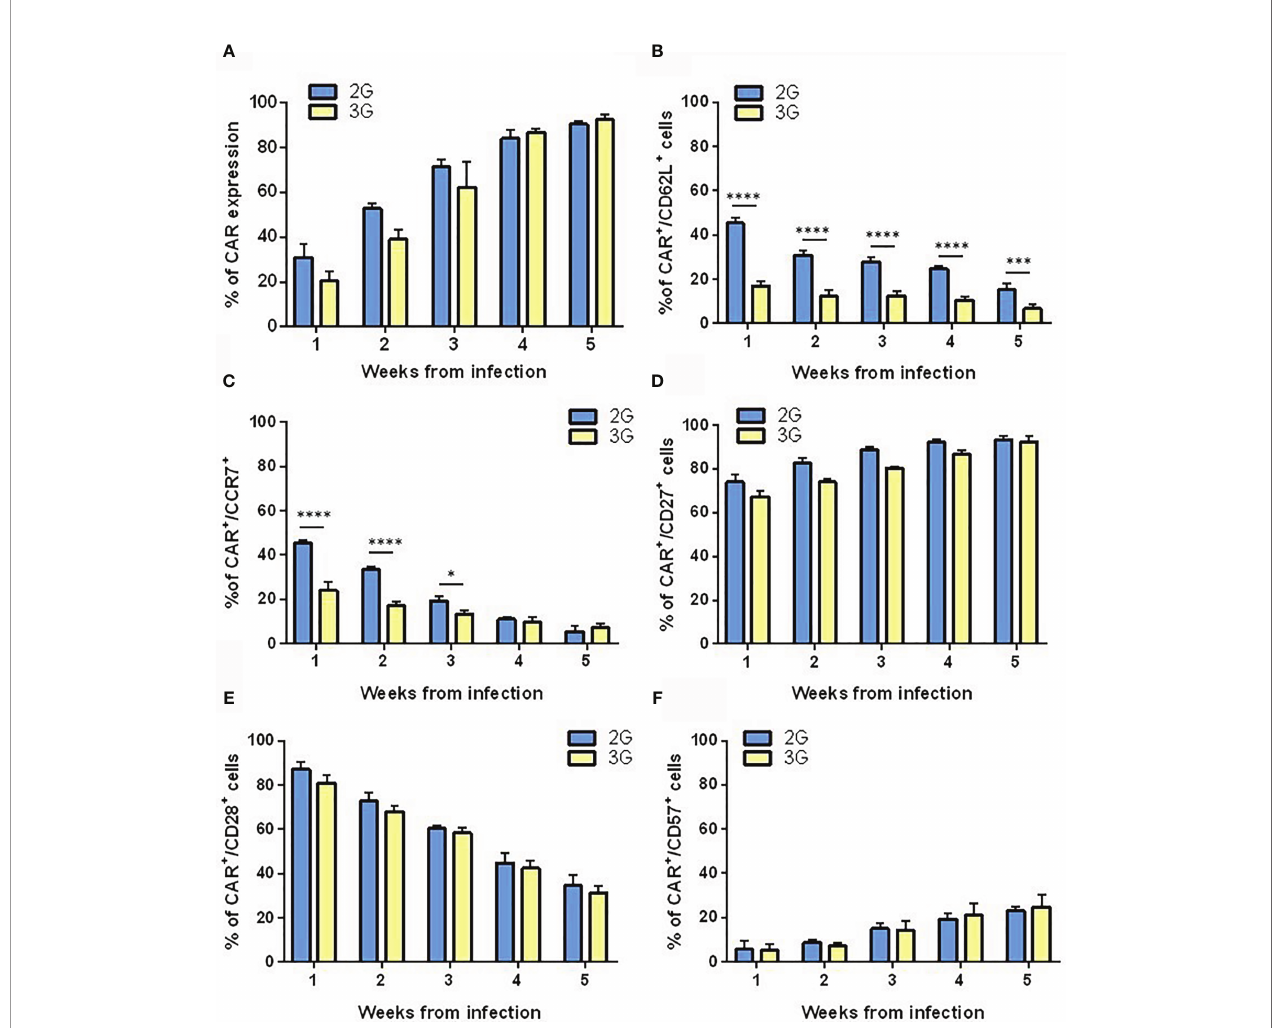
FIGURE 2 | Differentiation pattern of the 2G and 3G CAR-expressing populations. (A) 2G and 3G CAR expression after stimulation. Histograms report the percentage of 2G (light blue) and 3G (yellow) CAR + cells in LV CAR hPSMA/eGFP transduced T cell populations at different weeks from infection. Expression of (B) CD62L, (C) CCR7, (D) CD27, (E) CD28, and (F) CD57. All surface markers were evaluated in 2G and 3G CAR-expressing populations at different weeks from infection, as assessed by fl ow cytometry. Figures show the mean +/- SD of at least three independent experiments. *p < 0.05, ***p < 0.001, ****p < 0.0001 by two-way